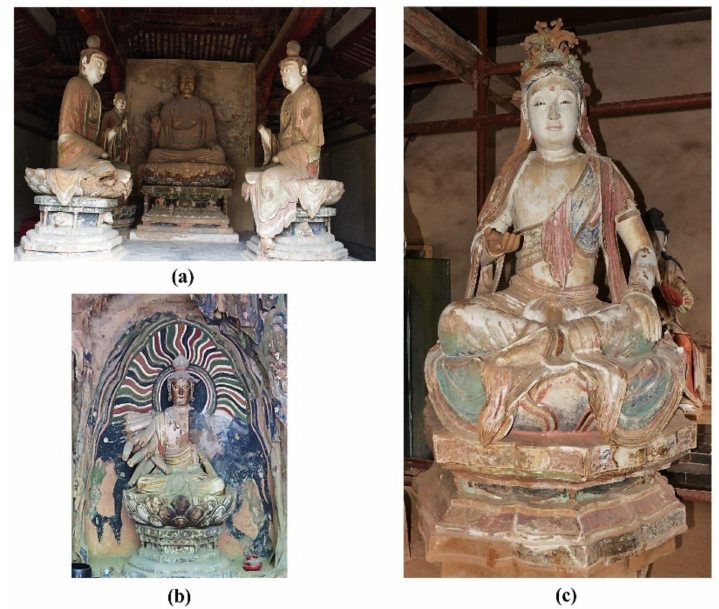
Figure 1. The halls and sculptures in the Qinglian Temple: ( a ) the interior of the Shangsibei Hall; ( b ) Sculpture of a Thousand Hand Guanyin statue in the Shangsibei Hall; ( c ) Sculpture of Bodhisattva Manjusri in the Xiasinan